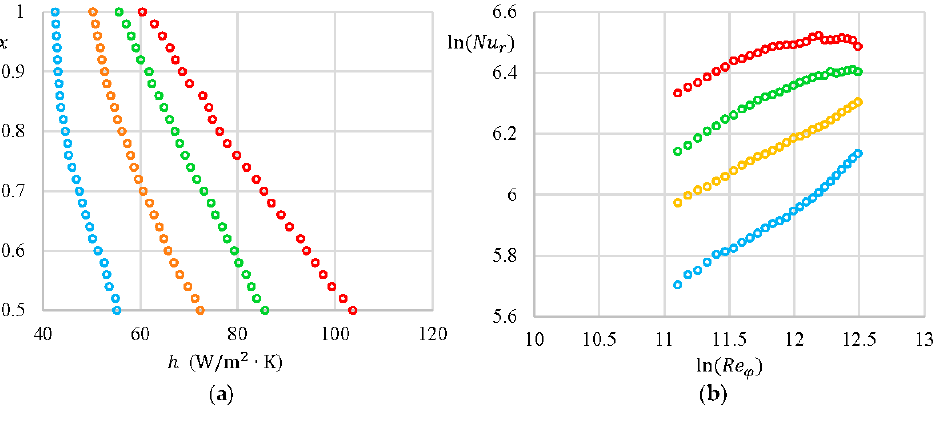
Figure 9. Characteristics of heat transfer at ς = 20% ( Re = 0.22 × 10 6 ) by measurements: ( a ) Variations of ℎ along the radius and ( b ) Variations of ln (𝑁𝑢 (cid:3045) ) versus ln (𝑅𝑒 (cid:3101) ) .